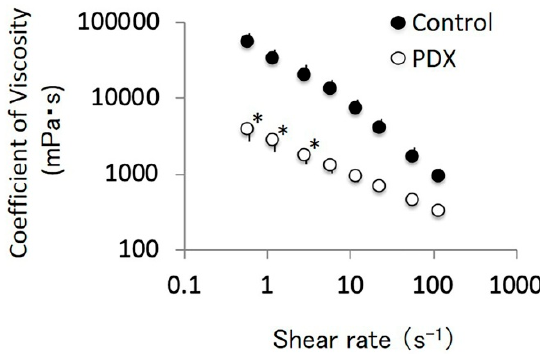
Figure 3. Effects of polydextrose (PDX) addition and shear rate on the cecal digesta viscosity. n = 6 per group for each shear rate. Data are expressed as means (histogram bars) and SEM (error bars). We found a statistically significant interaction between PDX addition and shear rate for the cecal digesta viscosity ( p = 0.001, two-way ANOVA). * p < 0.05 versus control group at each shear rate using the Tukey–Kramer method.